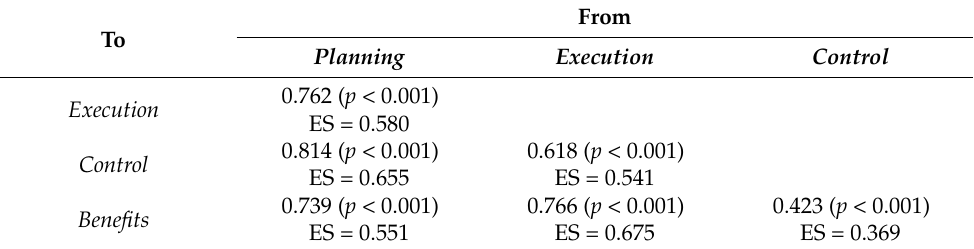
Table 8. Total effects.